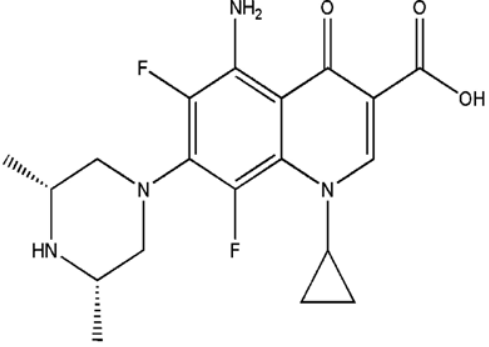
Fig. 1. Chemical structure of sparfloxacin